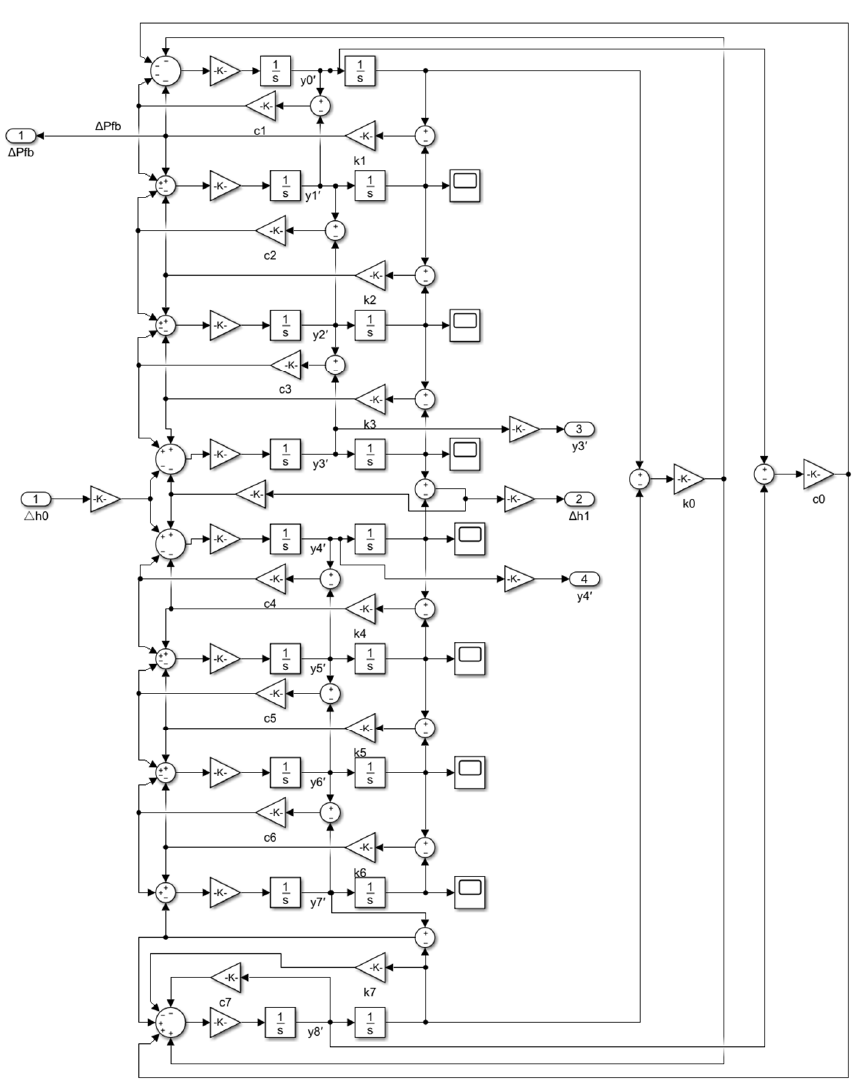
Figure 4. MATLAB/Simulink simulation diagram of mechanical vibration system of rolling mill.